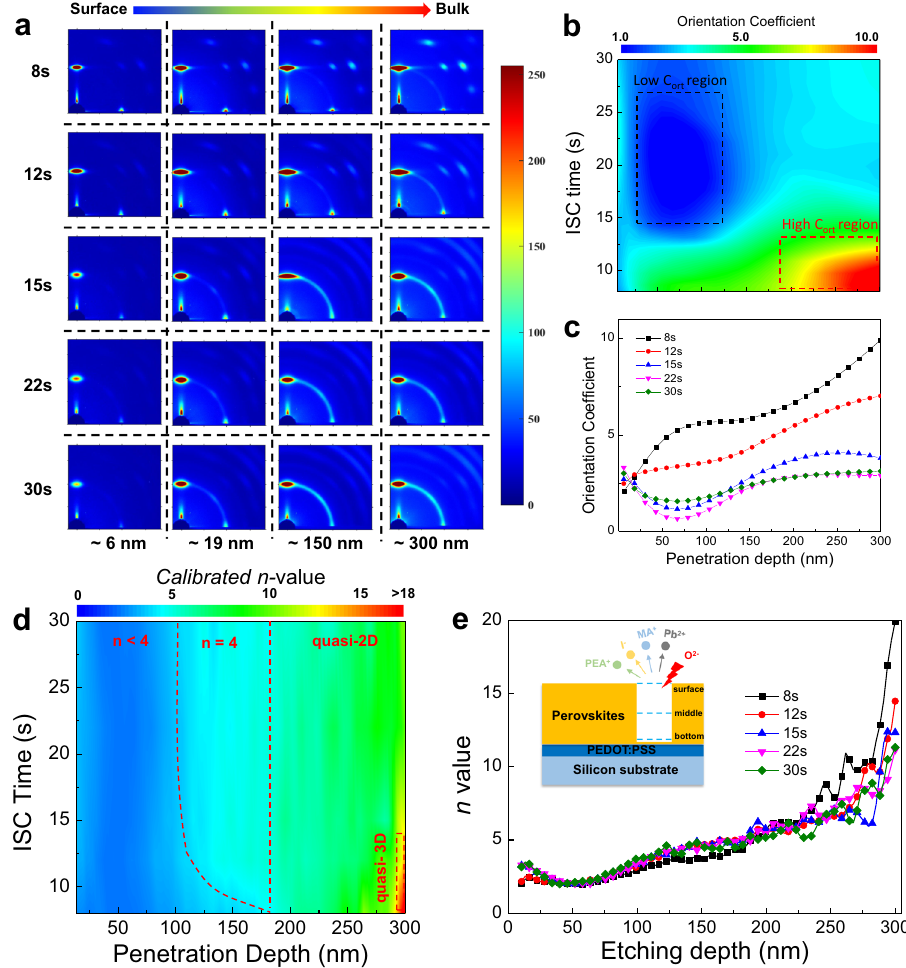
Fig. 3 Crystal orientation and phase distribution. a Evolution of GIWAXS patterns with various penetration depths and ISC times. b Mapping and the corresponding c line-cut pro fi les of C ort in PEA 2 MA 3 Pb 4 I 13 thin fi lms as a function of ISC time and depth. The black(red) dashed box represents the low(high) C ort region, respectively. d Mapping and e the corresponding line-cut pro fi les of n values in PEA 2 MA 3 Pb 4 I 13 thin fi lms as a function of ISC time and depth. The inset illustrates the ethcing and probing processes on the PEDOT:PSS coated silicon substrates during TOF-SIMS. The red dashed curve and vertical line in d separate the whole pane into n < 4, n = 4 and quasi-2D areas and the red dashed box marks the quasi-3D